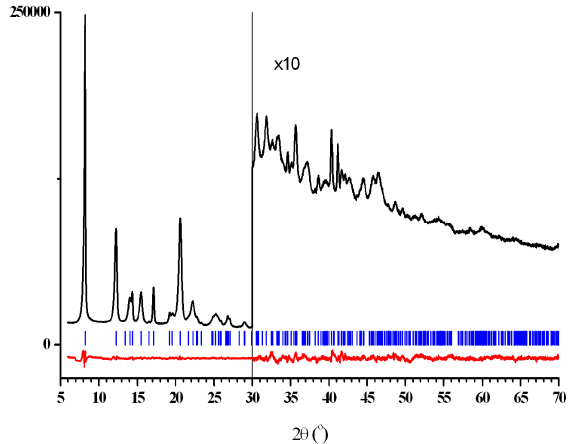
Figure 1. The Rietveld plot for [ Cu 2 (EDPB)•H 2 O] n , showing the experimental (black) and difference